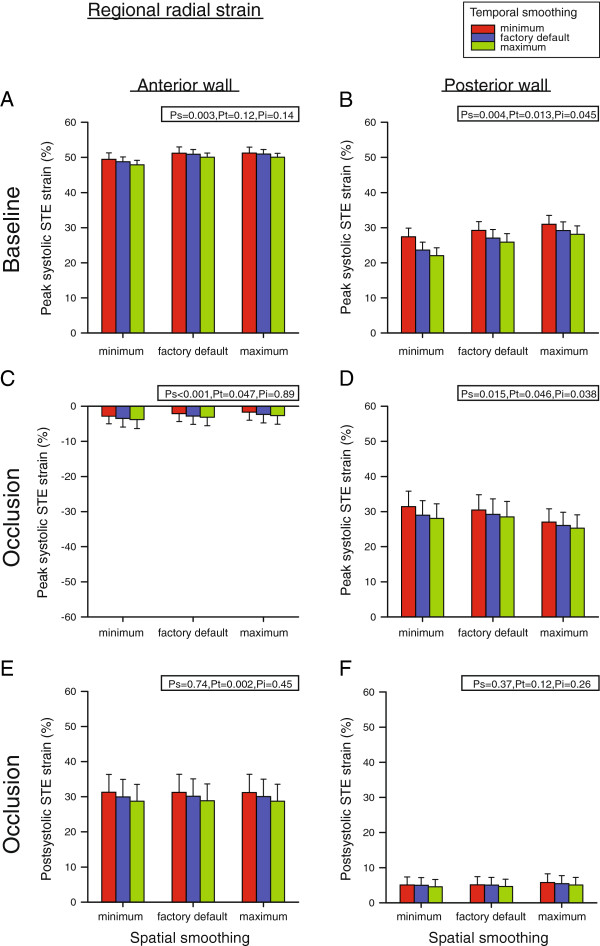
Regional radial peak- and postsystolic Speckle Tracking Echocardiography (STE) strain in the anterior and posterior myocardial wall at baseline (A and B) and after left anterior descending coronary artery occlusion (C - F). Measurements were performed with nine different combinations of spatial and temporal smoothing created by setting these parameters in turn to minimum, factory default and maximum. Mean values of seven animals, error bars represent SEM. Ps, Pt and Pi as defined in Figure 4.